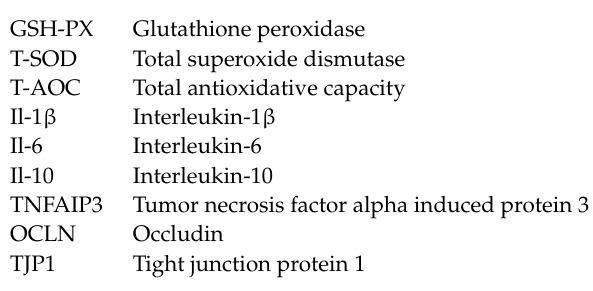
microflora, Figure S2: The representative images showing the effects of dietary probiotics on jejunal and ileal histomorphology of geese at the age of 70 days, Table S1: The ingredient and nutritional compositions of basal diet, Table S2: Effects of probiotics supplementation on the relative lengths and weights of different intestinal segments in the geese at the age of 70